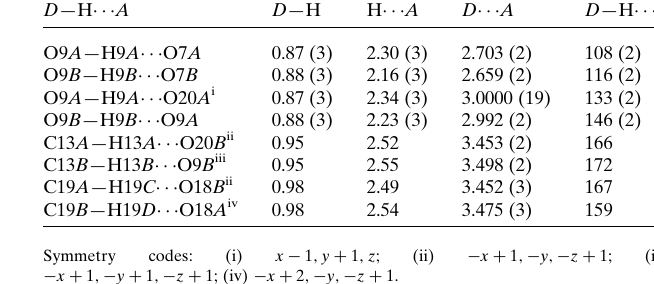
Table 2 Experimental details.